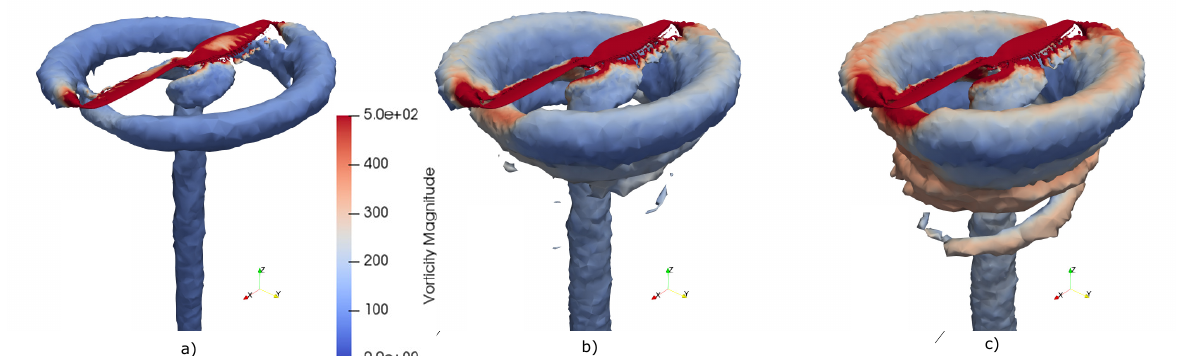
Figure 17. Q-criterion contours, colored by vorticity magnitude: ( a ) Re = 3.53 × 10 4 , ( b ) Re = 7.93 × 10 4 , ( c ) Re = 1.15 × 10 5